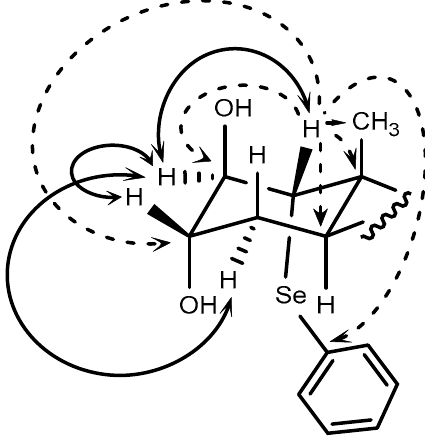
Figure 2. Relevant data from COrrelation SpectrocpY (COSY and heteronuclear multiple bond correlation (HMBC) experiments for the structure of the compound 9 (COSY correlations – plain line, HMBC correlations–dashed line, -- means no relation).